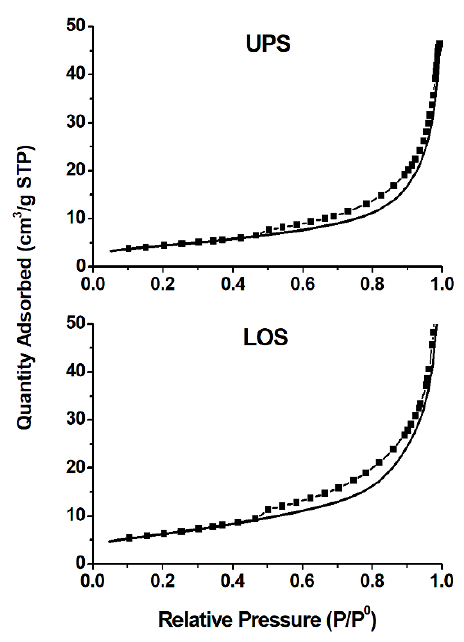
Figure 10. Nitrogen gas adsorption-desorption isotherms of the UPS and LOS samples.